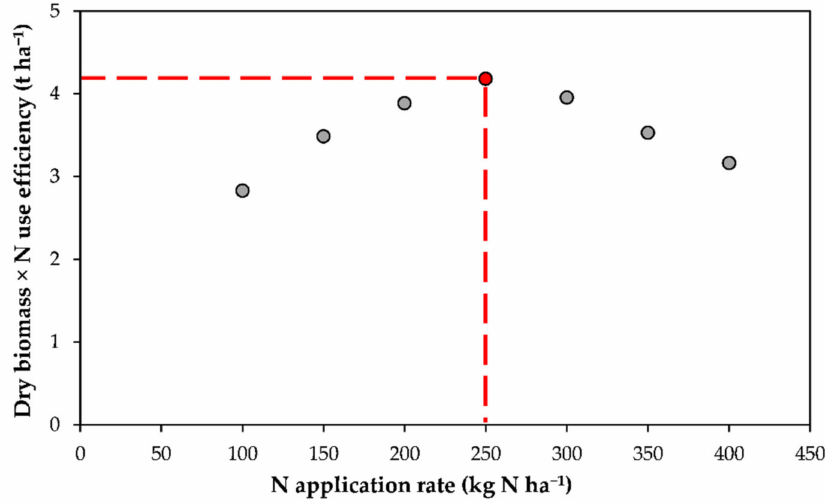
Figure 1. Optimal N application rate determination process: the red dotted lines define the N application rate when the maximum between dry biomass and N use efficiency (NUE) is